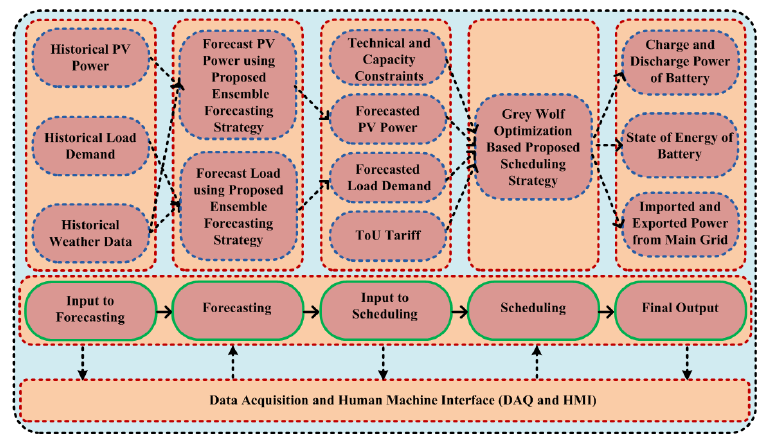
Figure 2. Proposed microgrid energy management